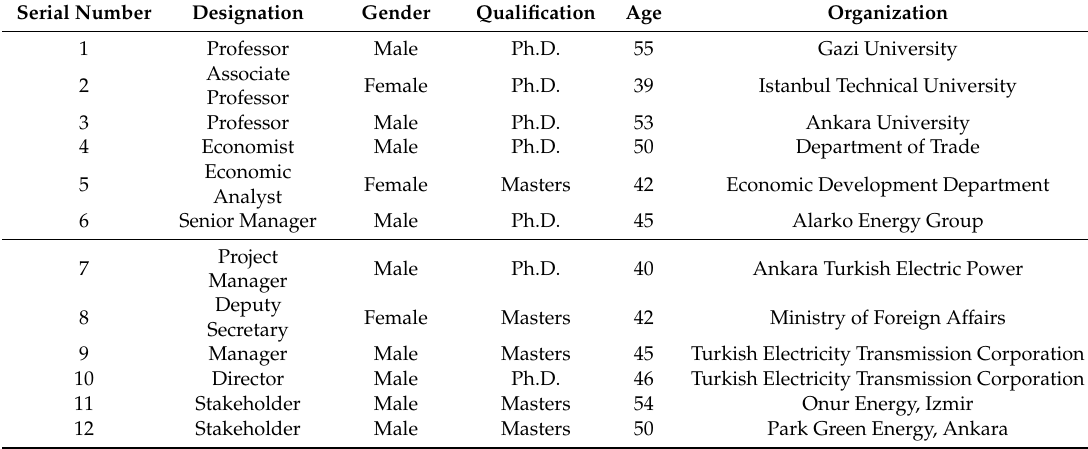
Table A2. Demographic information of the experts.